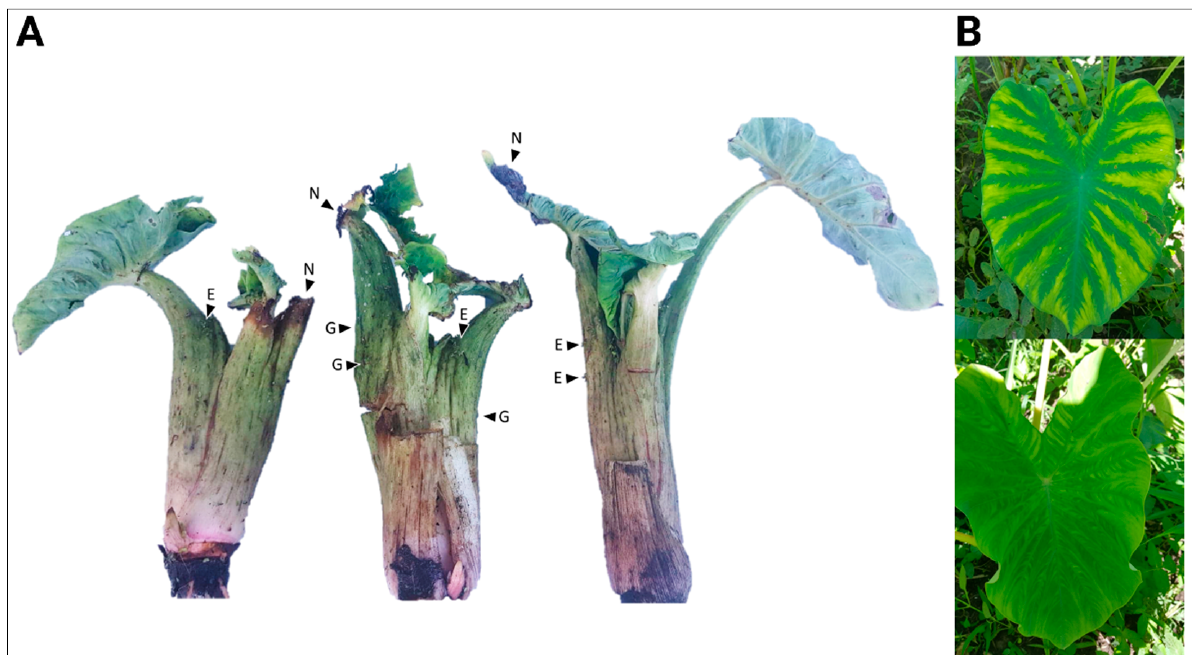
Figure 1. Symptoms of taro plants with and without ABVC symptoms. ( A ) Symptoms of the three taro plants with ABVC symptoms collected from Kokoda and Popondetta in Papua New Guinea (PNG). E = enations; N = necrosis; G = galls. ( B ) Two taro plants sampled from Girua, PNG presenting symptoms of interveinal chlorosis, but not ABVC.